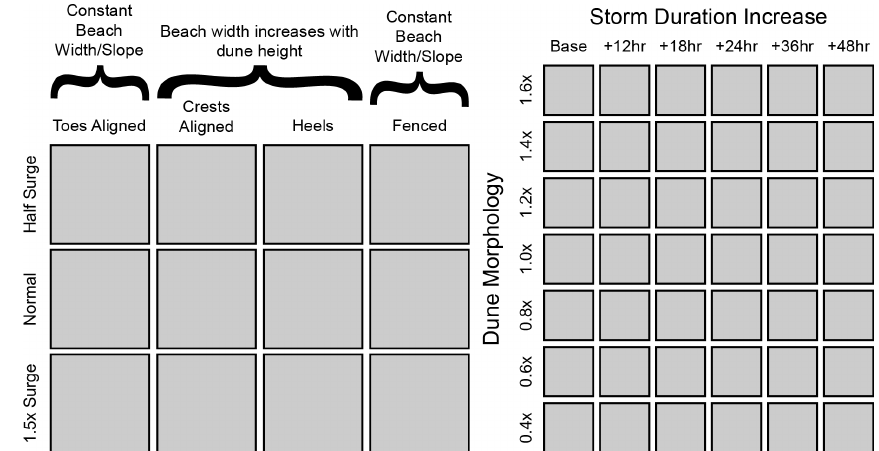
Figure 7. Schematic overview of XBeach simulations. For every combination of storm intensity and dune alignment shown in the left matrix (12 total), we ran every combination of dune shape and storm duration shown in the right matrix (42 total).